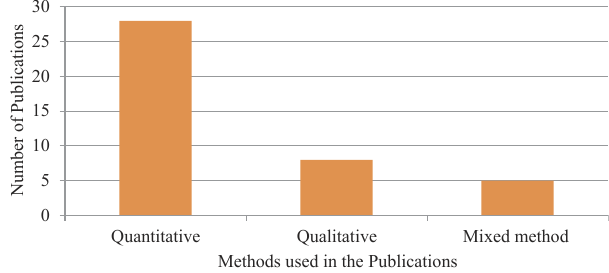
Figure 2. No. of papers on drivers of ESS published under each research